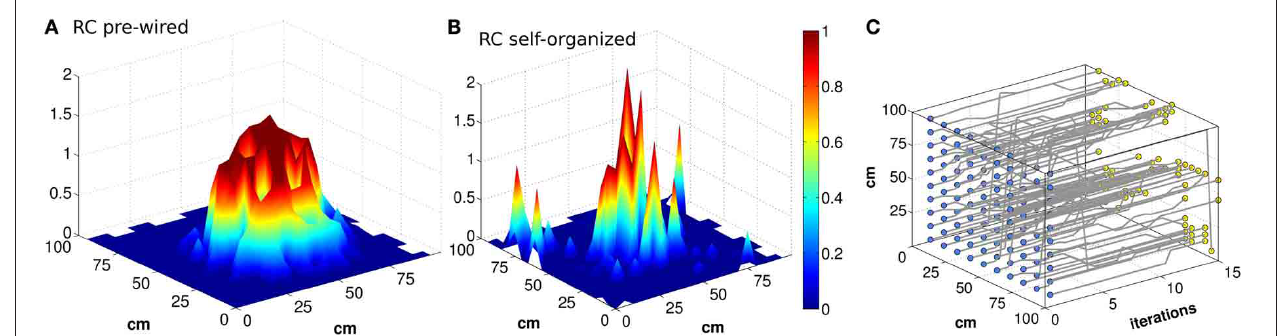
FIGURE 1 | Bumps of activity are rough, and tend to drift. Activity packets showing the localization of the firing pattern, when the virtual rat is in the position of coordinates ( x , y ) = (55,45) ( A and B ). The firing rates of all the units active in the given environment, among N CA 3 = 1500 units, are plotted in the position of their (main) place field centers, when noise is very low ( δ = 0 . 002). The attractor bump in a network with connectivity pre-wired